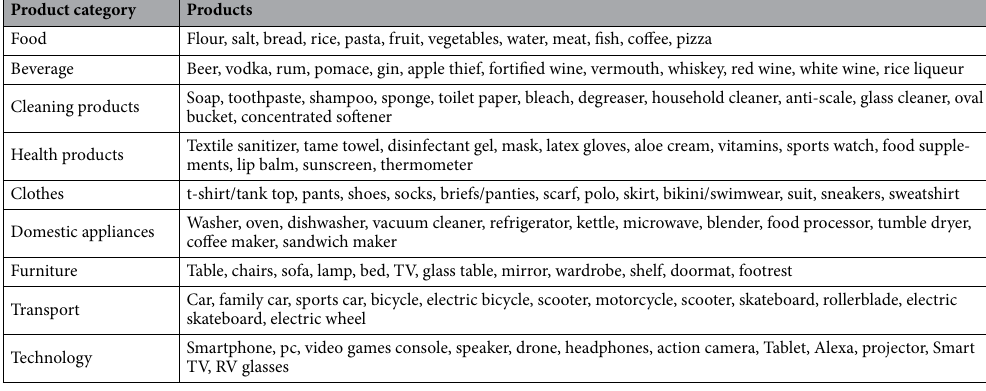
Table 1. Product